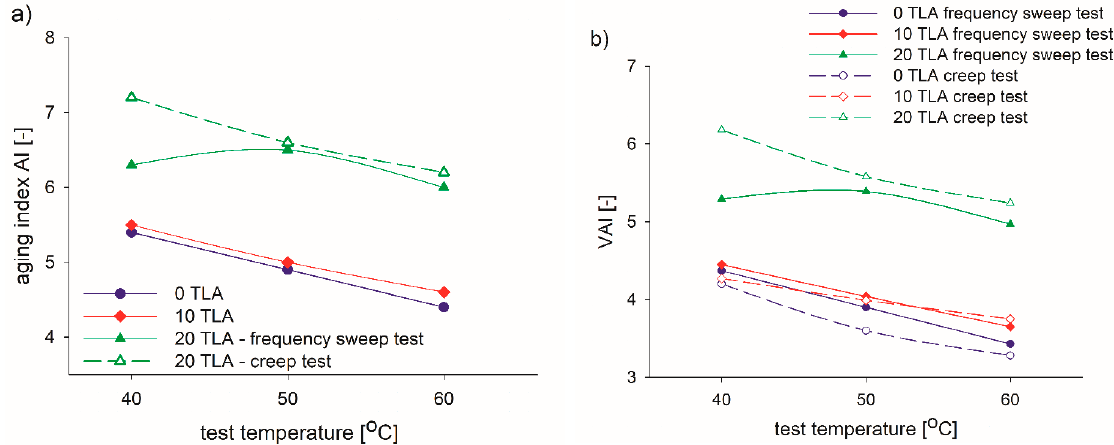
Figure 12. Viscosity aging indices for the TLA-modified binders: ( a ) AI and ( b ) VAI.